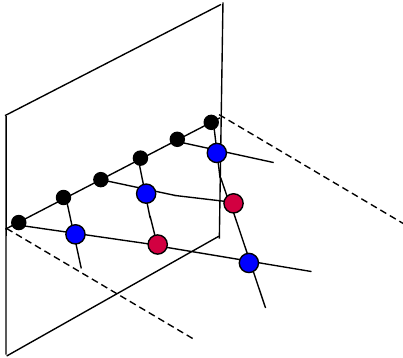
Figure 2: A cartoon of a tensor network. The black dots are initial Hilbert space degrees of freedom, say spins. The blue dots denote tensors which act on the spins as disentanglers while the red dots act as isometries. The emergent geometry of the network is reminiscent of the bulk geometry in AdS /